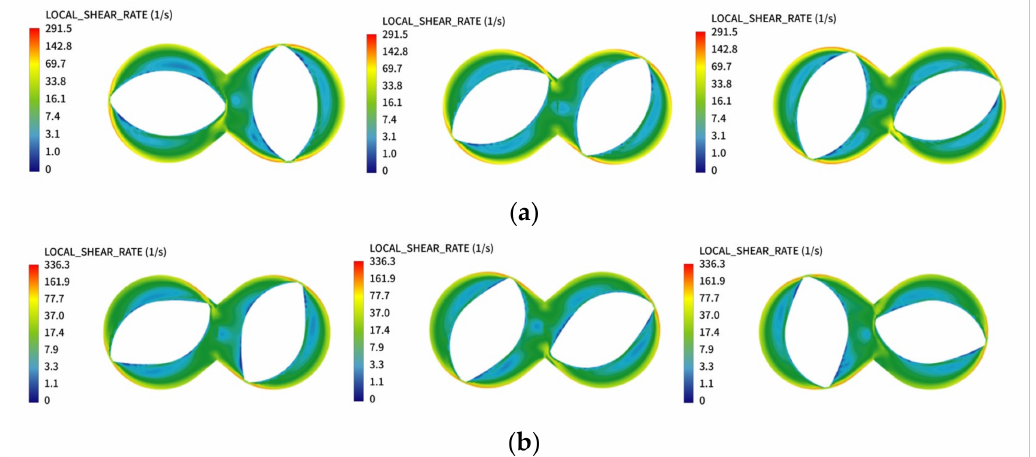
Figure 8. Pressure field of the rotor ( a ) before and ( b ) after optimization.